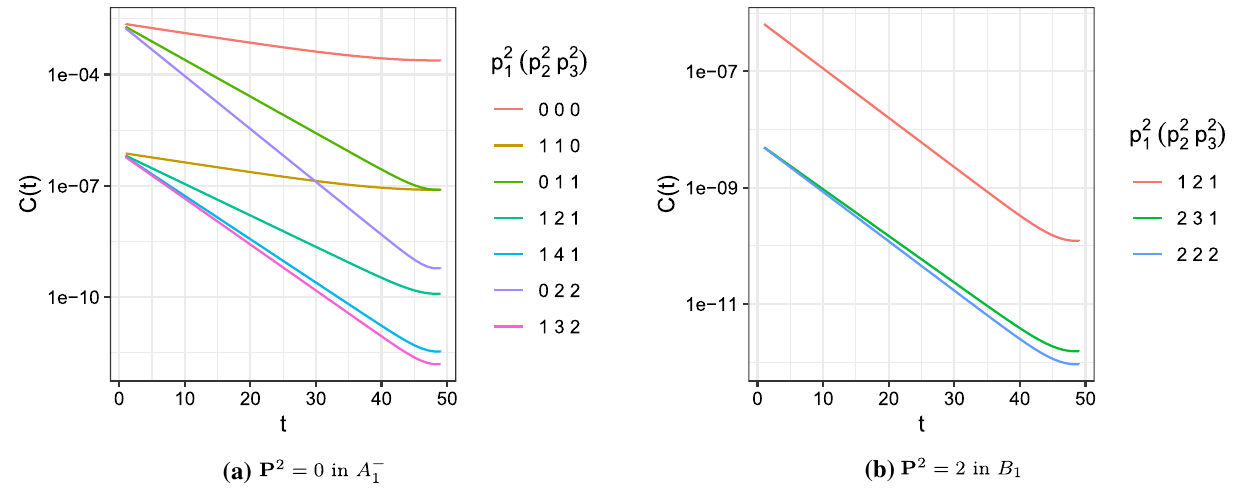
Fig. 5 Possible thermal contributions to the three-pion correlator matrix in the cA2.09.48 ensemble. Each line corresponds to a particular combi- nation of the individual particle momentum magnitudes of the one-pion ( p 1 ) and the two-pion system ( p 2 and p 3 )